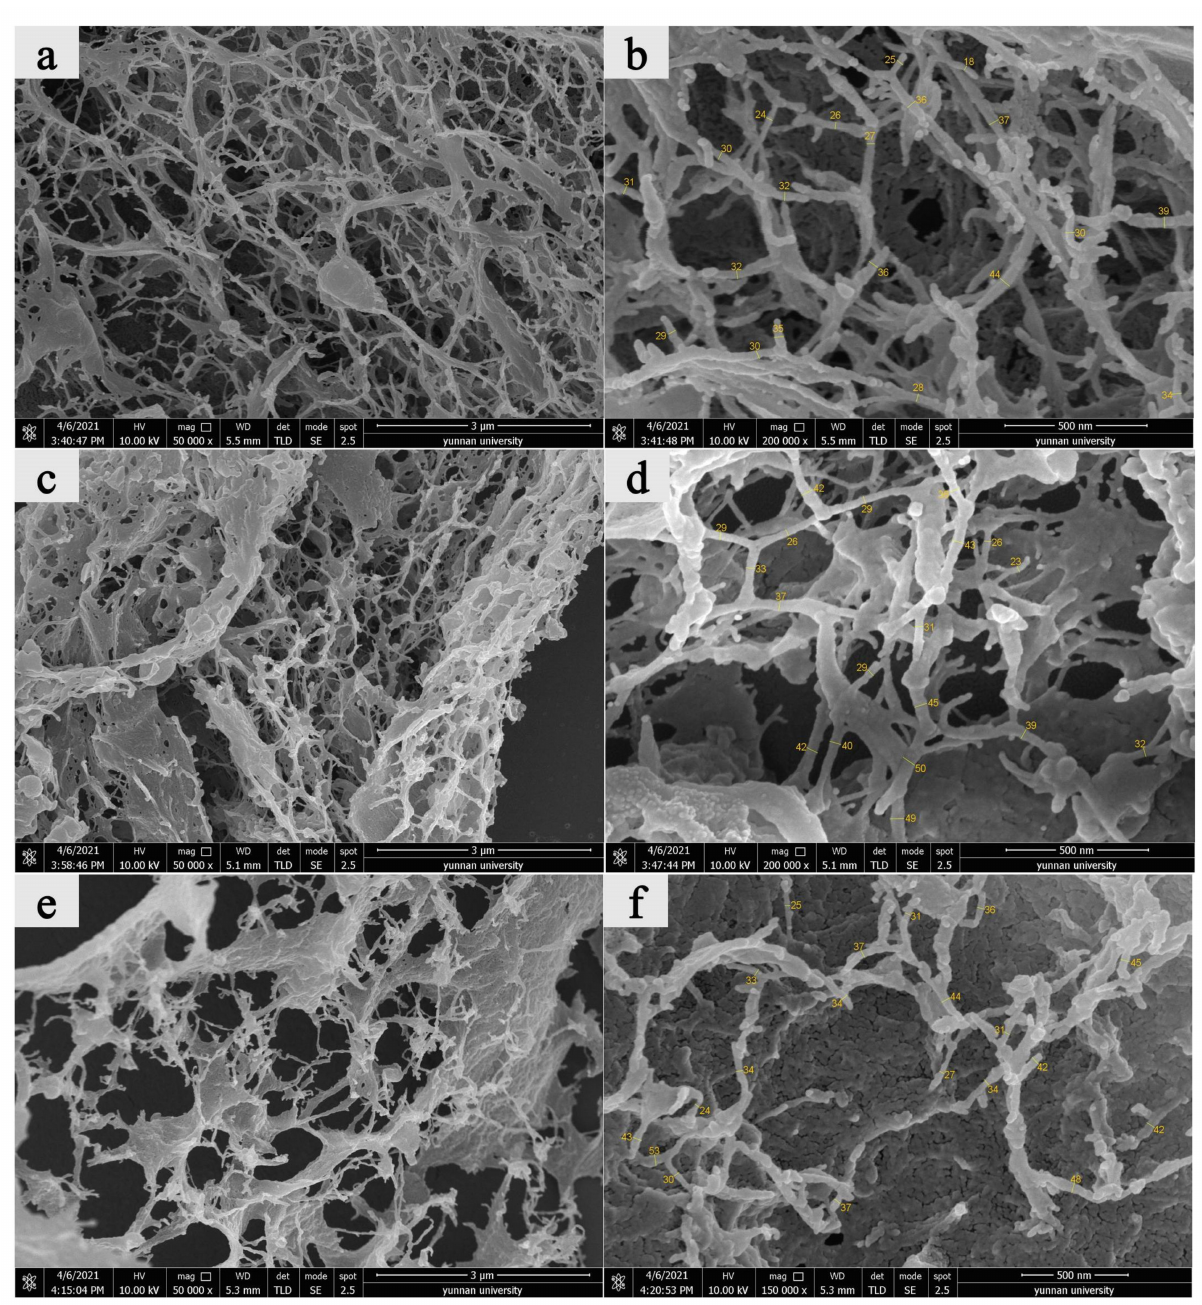
Figure 5. FESEM micrographs of CNPs prepared from: ( a , b ) pine needles, ( c , d ) poplar leaves, ( e,f ) bamboo